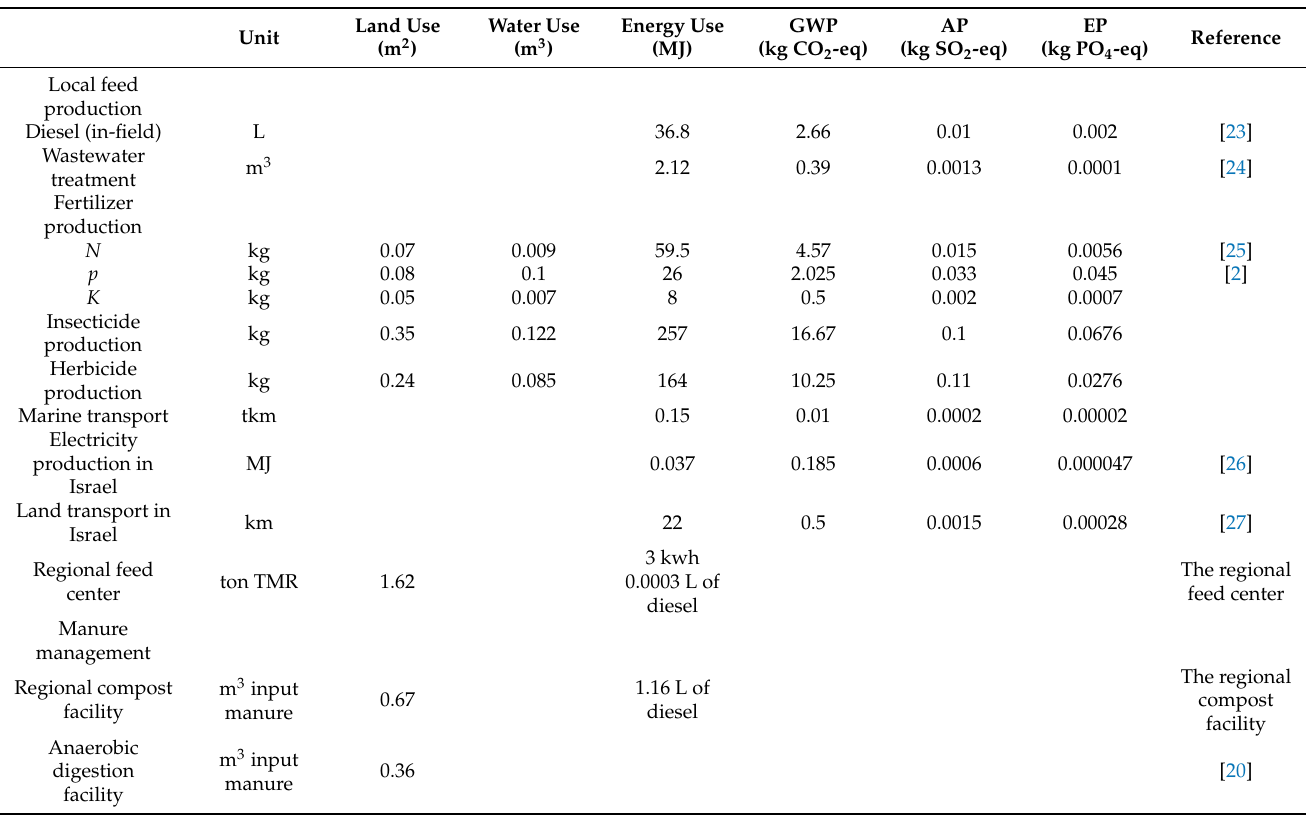
Table 2. Conversion factors.